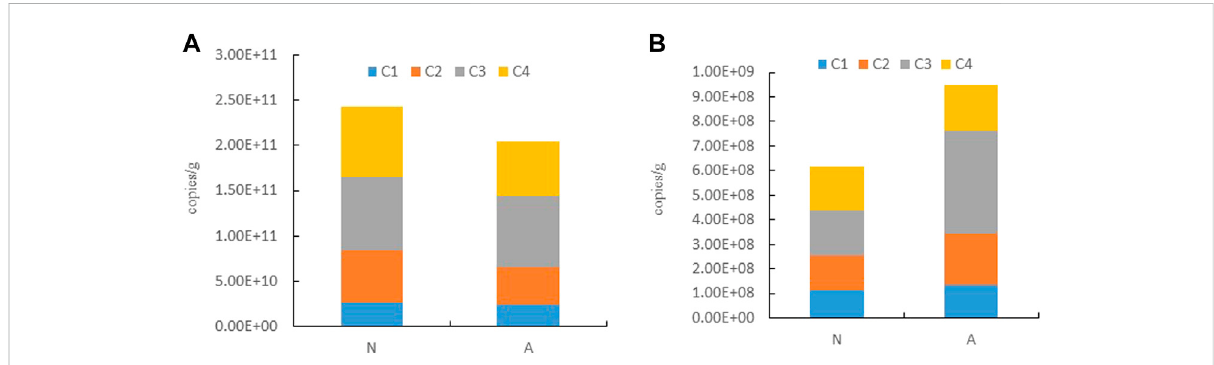
FIGURE 1 Abundance of denitrifying and anammox bacteria in the two conditions (A) denitrifying bacteria. (B) anammox bacteria. N: denitri fi cation group. A: anammox group. C1, C2, C3, and C4 indicate the four sediments